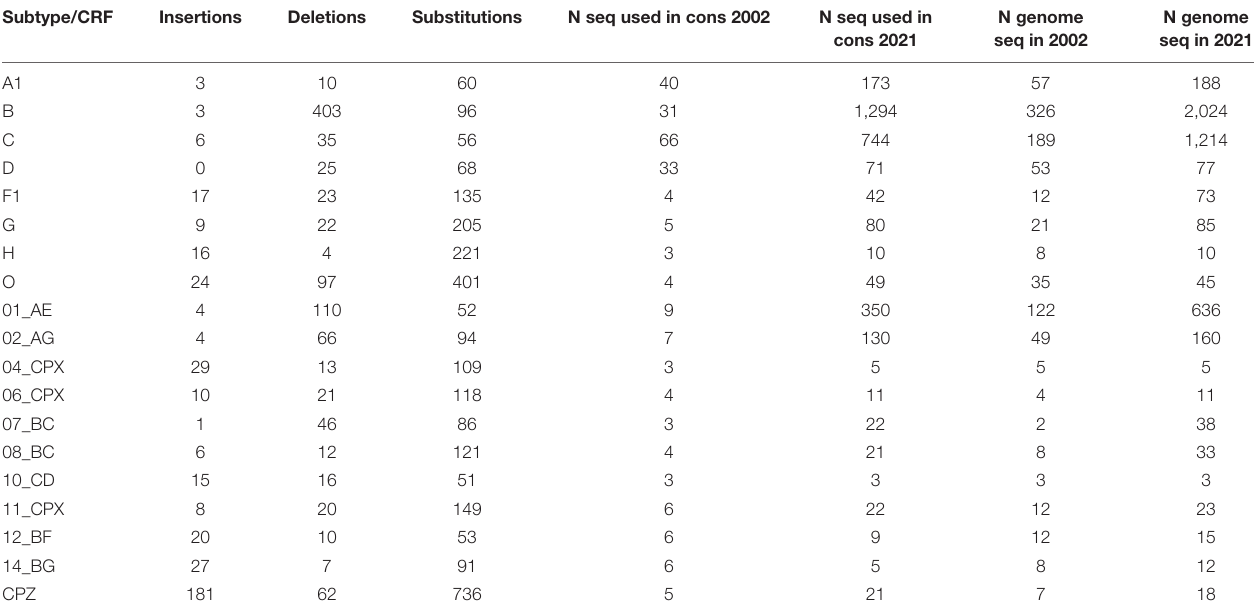
FIGURE 2 | Principal distances between consensus and database sequences. In this cartoon, sequences evolve through mutations over time, radiating out from the origin (center of circles) and sampled through time (A) . At some time (red circle) all sequences sampled until then (red dots) are used to compute a consensus sequence (red square). Individual distances from that consensus sequence to all sequences available until then form a distance distribution in panel (B) , displayed as a red violin plot of all distances r . An example of a r distance is shown in panel (A) . At a later time (blue circle), a new consensus sequence is computed (blue square), and, similarly, all distances ( b ) to sequences available until that time (red and blue dots) form the blue distribution in panel (B) . The distance between the first and second consensus sequences is s . We can also consider distances from the second consensus sequence to samples collected only available until the first consensus was made ( y ). Note that some samples that originated from a time before the first consensus was made were not publicly available until the second consensus was made (blue dots inside red circle). TABLE 1 | 2002–2021 HIV-1 consensus sequence